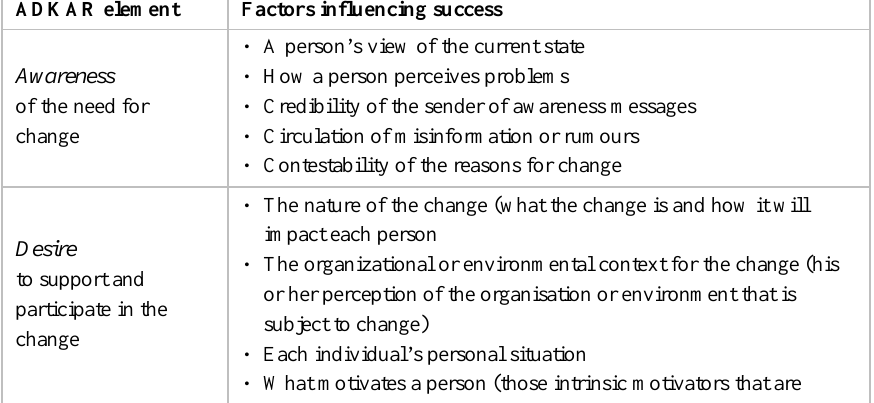
Table 1. Factors influencing each element of the ADKAR model (Hiatt, 2006, p.45) ADKAR